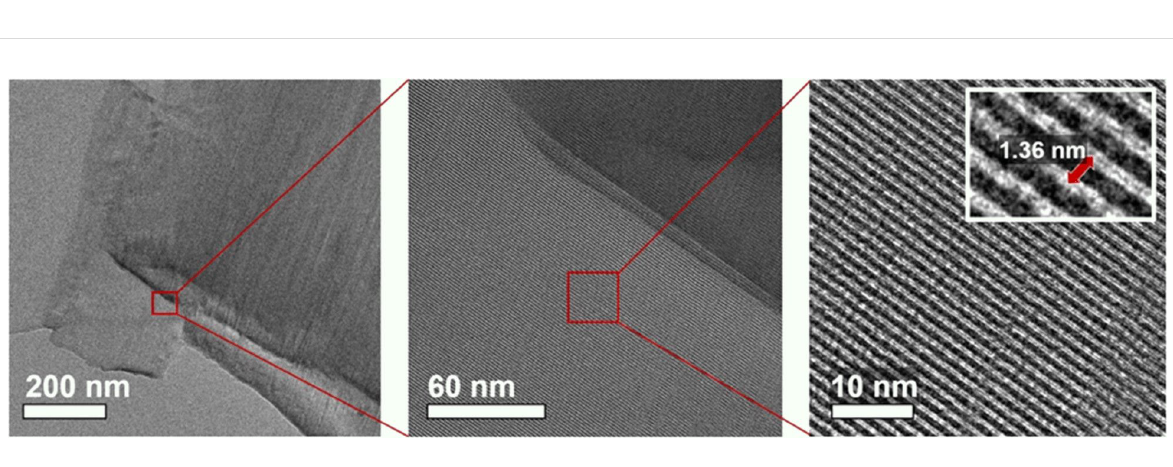
Figure 6: TEM micrographs for the Na,K-ETS-10 material obtained with different magnifications demonstrating a highly ordered ETS-10 crystal struc- ture. Other images obtained with different ETS-10 crystals can be found in section S9 of Supporting Information File 1.